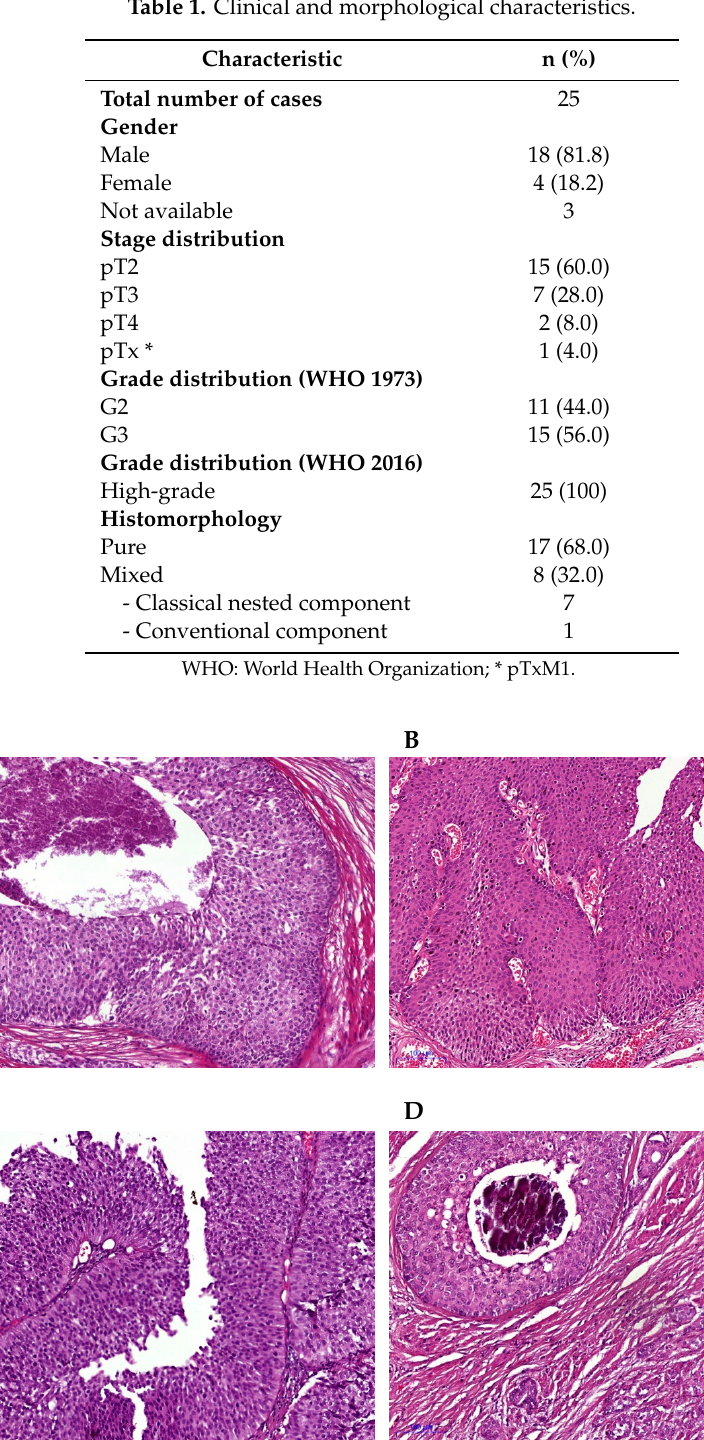
Figure 1. ( A ) Large nested urothelial carcinoma: typical histomorphology showing large-sized well delineated nests with bland cytology infiltrating the detrusor muscle; ( B ) inverted growth pattern in LNUC; ( C ) Papillary-like exophytic component; ( D ) LNUC combined with classical nested variant urothelial carcinoma (NVUC) (all H&E; all 100 fold original